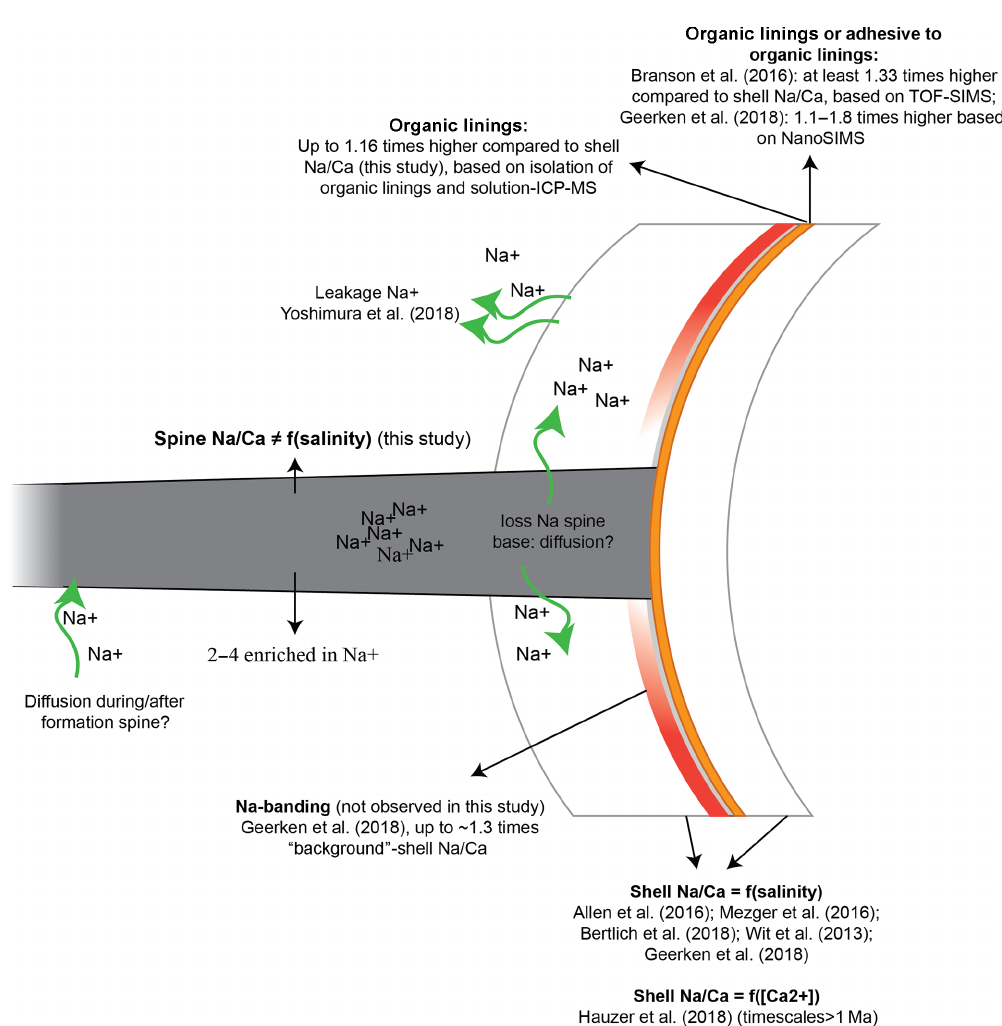
Figure 7. Potential processes influencing the Na / Ca composition of the shell, spines and organic linings. Na from spines may be transported to the surrounding seawater or into the adjacent calcite with a relatively low Na / Ca. The latter may be difficult to distinguish from mixing of material from the spine and that of the low-Na / Ca